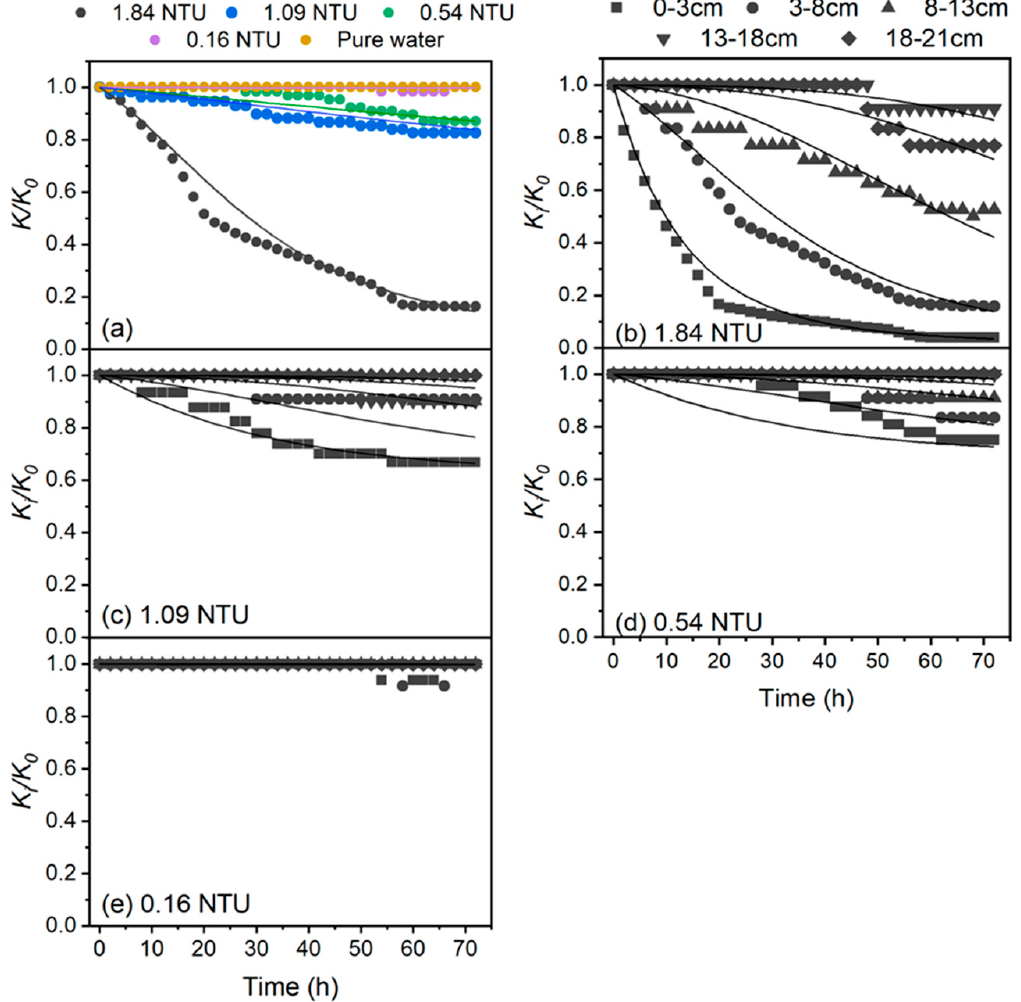
Figure 5. Experimental and simulated values of K/K 0 ( a ) and K i /K 0 (i = 1, 2, 3, 4, 5) ( b – e ) for four sets of experiments over time.